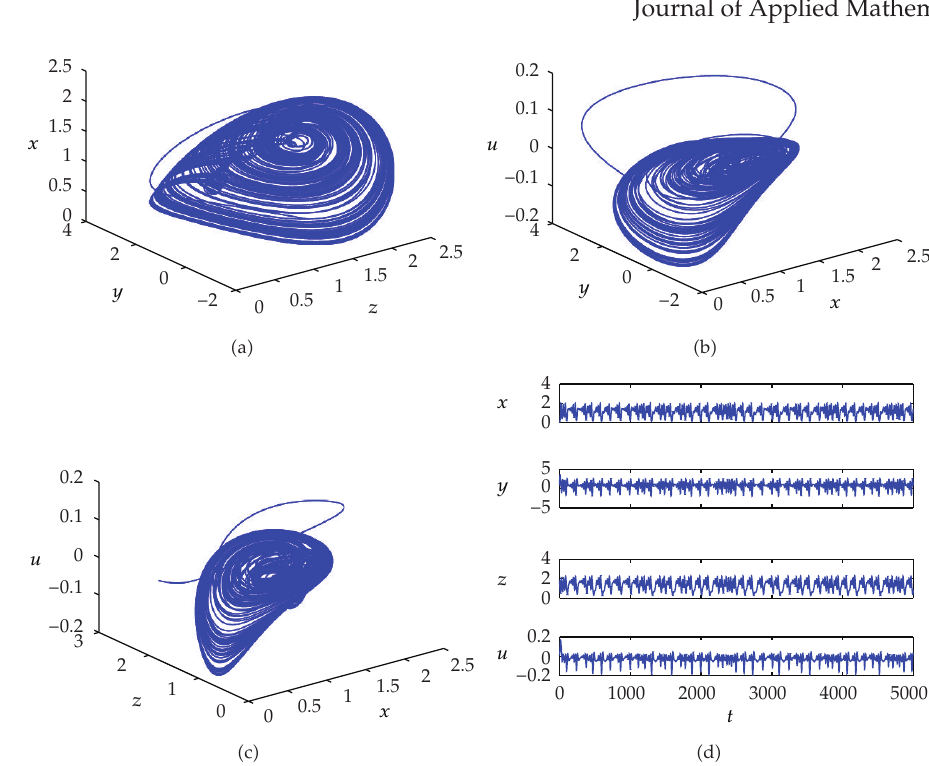
Figure 1: A four-dimensional energy-saving and emission-reduction chaotic